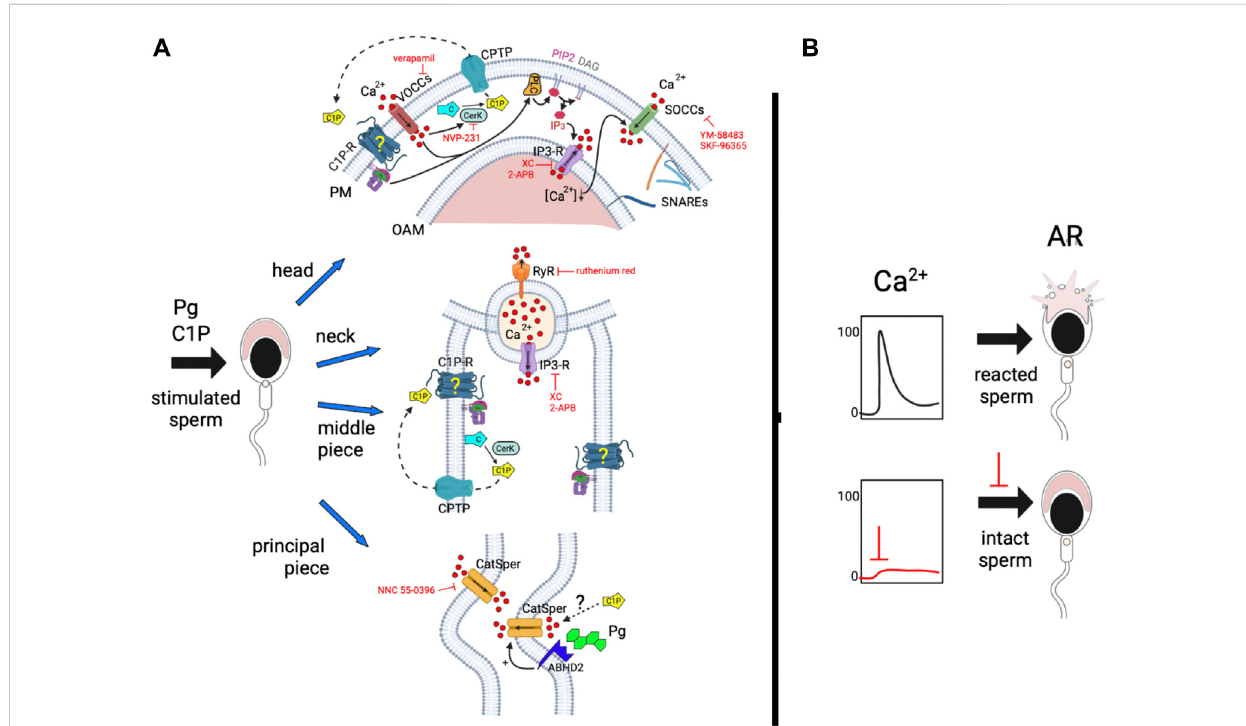
FIGURE 6 Scheme of the working model hypothesized for C1P/CERK pathway in acrosome exocytosis. (A) We propose that C1P interacts with a Gi-coupled receptor (C1P-R) activating VOC channels and a heterotrimeric Gi-protein. The transient calcium augment could be activating the CERK through the Ca 2+ /calmodulin-binding motif. The kinase phosphorylates ceramide to C1P, which can be transported through the plasma membrane to the extracellular environment by aC1P transfer protein (CPTP).Once outside, it can interact with its receptor amplifying the signaling pathway. Calcium increase and the heterotrimeric Gi-protein switch on a PLC which hydrolyzes phosphatidylinositol 4,5-bisphosphate (PIP 2 ) producing DAG and IP 3 . The last one binds to IP 3 -sensitive calcium channels, present on the outer acrosomal and redundant nuclear envelope (RNE) membranes, inducing calcium ef fl uxfromthereservoirs.The voidingofthestores triggerstheopening ofSOCCsattheplasma membrane allowingasustained calciumincrease.Atthe same time, C1P, due to the fi rst calcium wave can be causing the opening of ryanodine sensitive-calcium channels (RyR) present in the RNE. CatSper is a multimeric voltage-activated channel, negatively regulated by 2-arachidonoylglycerol (2-AG), which is hydrolyzed by the lipid α / β hydrolase domain- containing protein 2 when Pg binds its receptor. Given that C1P-induced AR requires CatSper activity, we suppose that the sphingolipid can set off CatSper via an unknown, alternative mechanism or by using the same machinery utilized by Pg. The last possibility makes sense due to the CERK activity requirement for Pg-triggered exocytosis. On the other hand, C1P drives SNARE (SNAP receptor) complex assembly during sperm. (B) C1P-elicited exocytosis is a complex mechanism that demands the participation of multiple calcium channels to reach a sustained [Ca 2+ ]i necessary for the ef fi cient signaling conducting human sperm